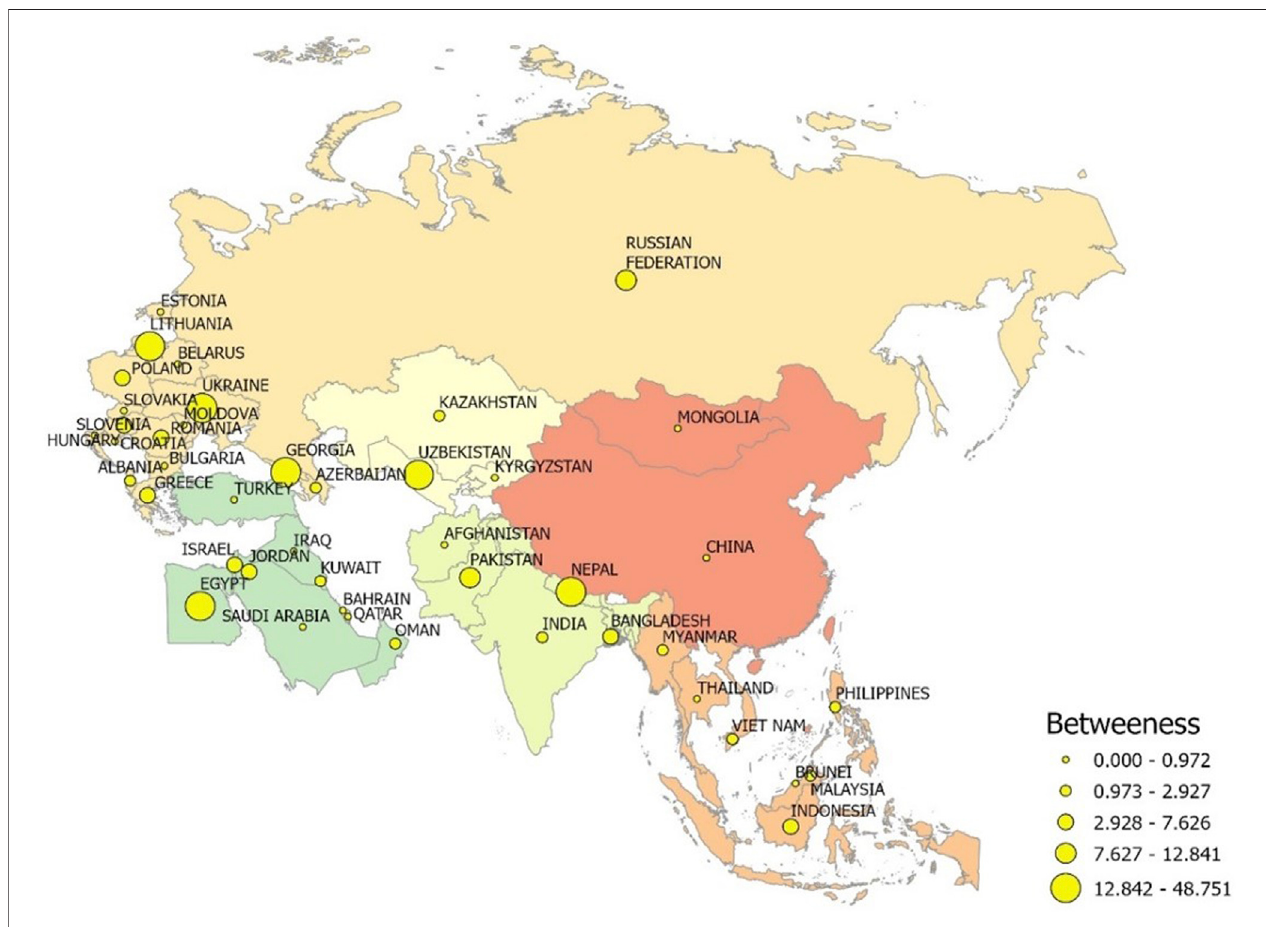
FIGURE 4 | Betweeness of environmental risk in the